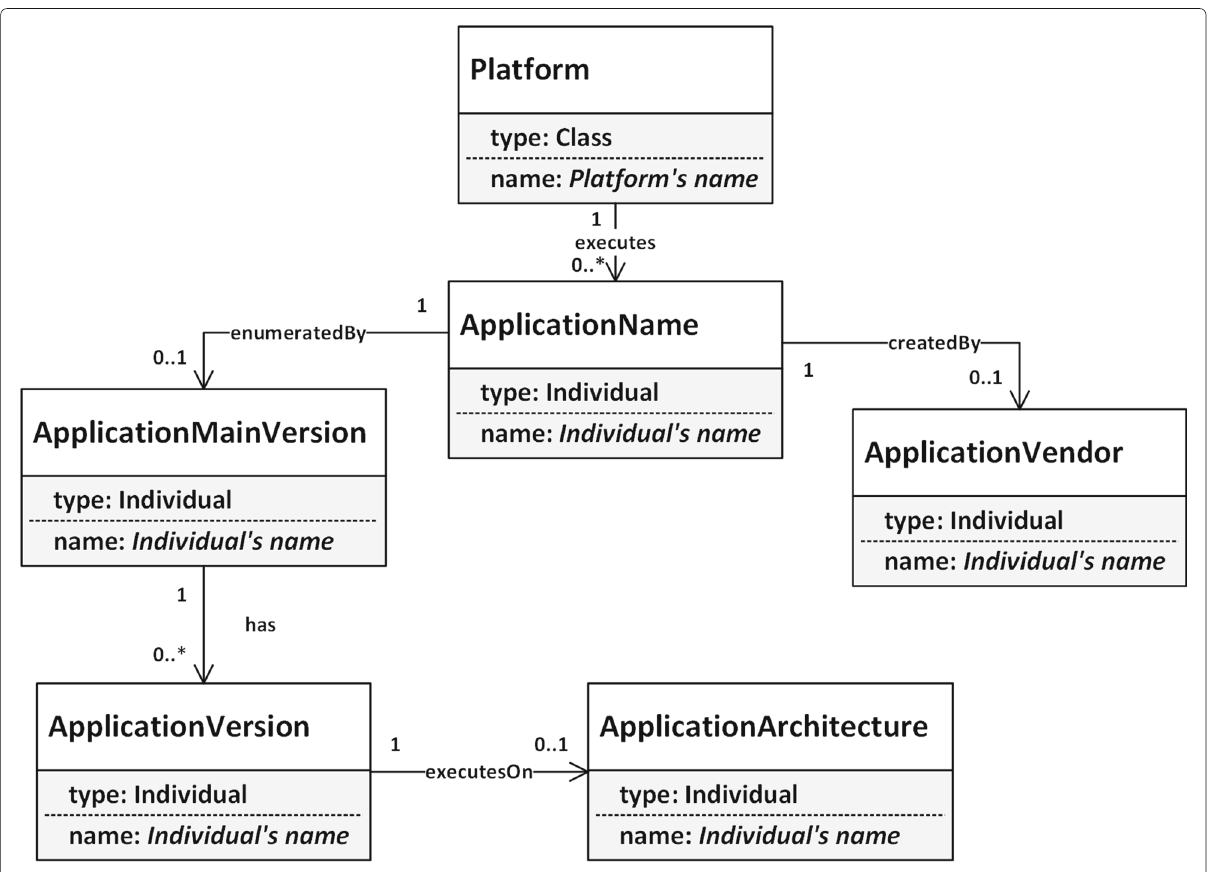
Fig. 4 Standardization of application software names